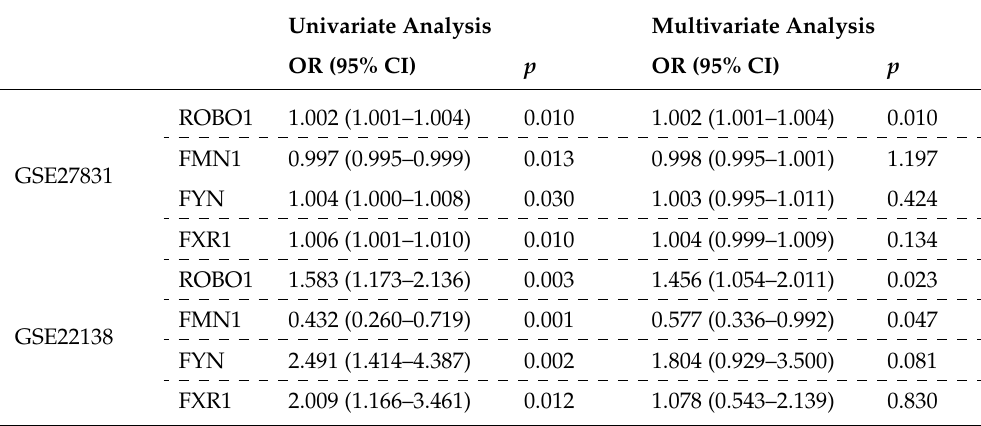
Table 2. Logistic regression analysis of hub genes affecting metastasis of the study patients.